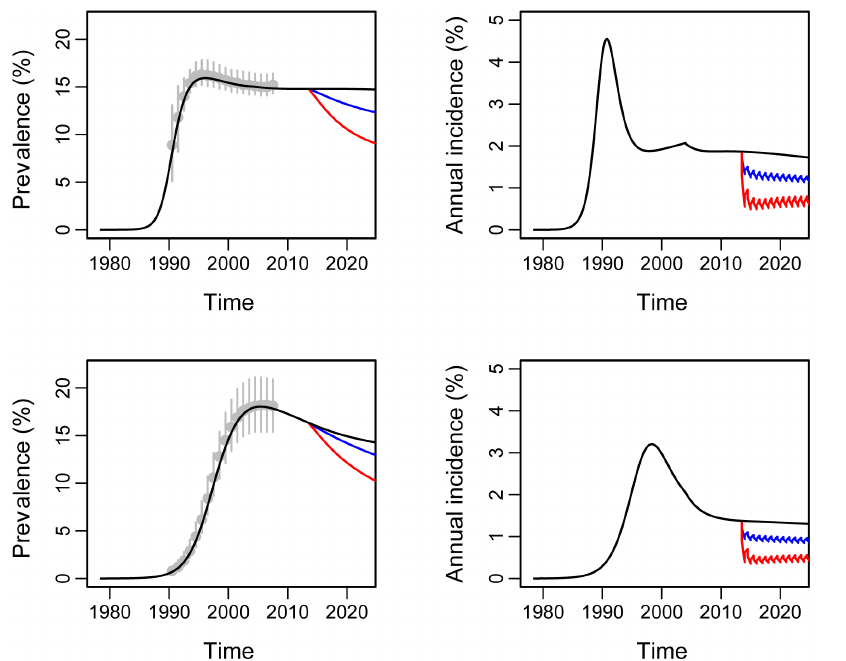
Figure 3. Model fit and projections under central target scenario for Zambia (top row) and South Africa (bottom row). Left panels show HIV prevalence and right panels show annualized HIV incidence over time. The red, blue and black lines correspond to arms A, B and C respectively. The grey dots and error bars are the UNAIDS HIV prevalence estimates [37].